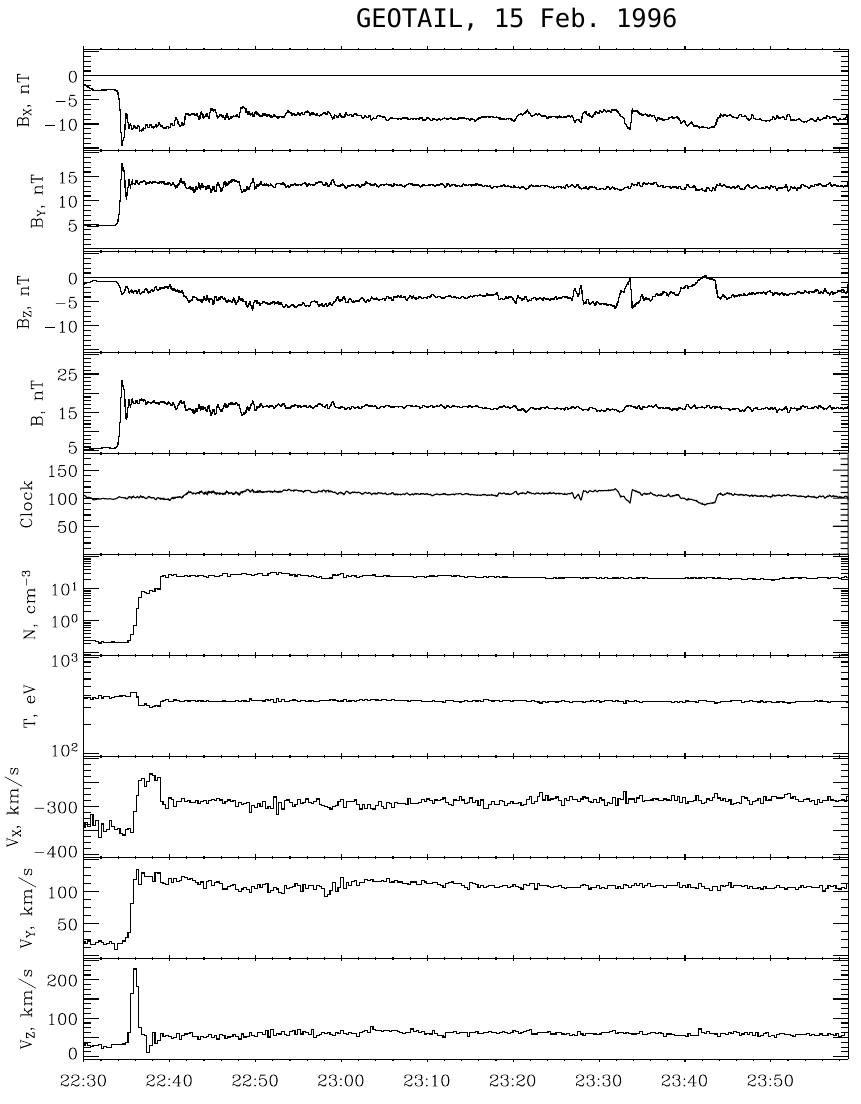
Fig. 1. Geotail magnetic field and plasma data are plotted for Interball observations of the LLBL on 15 February 1996. From top to bottom are shown: three components of the magnetic field (GSM), magnitude of the magnetic field, clock angle defined as tan 1 (B YGSM /B ZGSM ) , number density, temperature and three velocity components